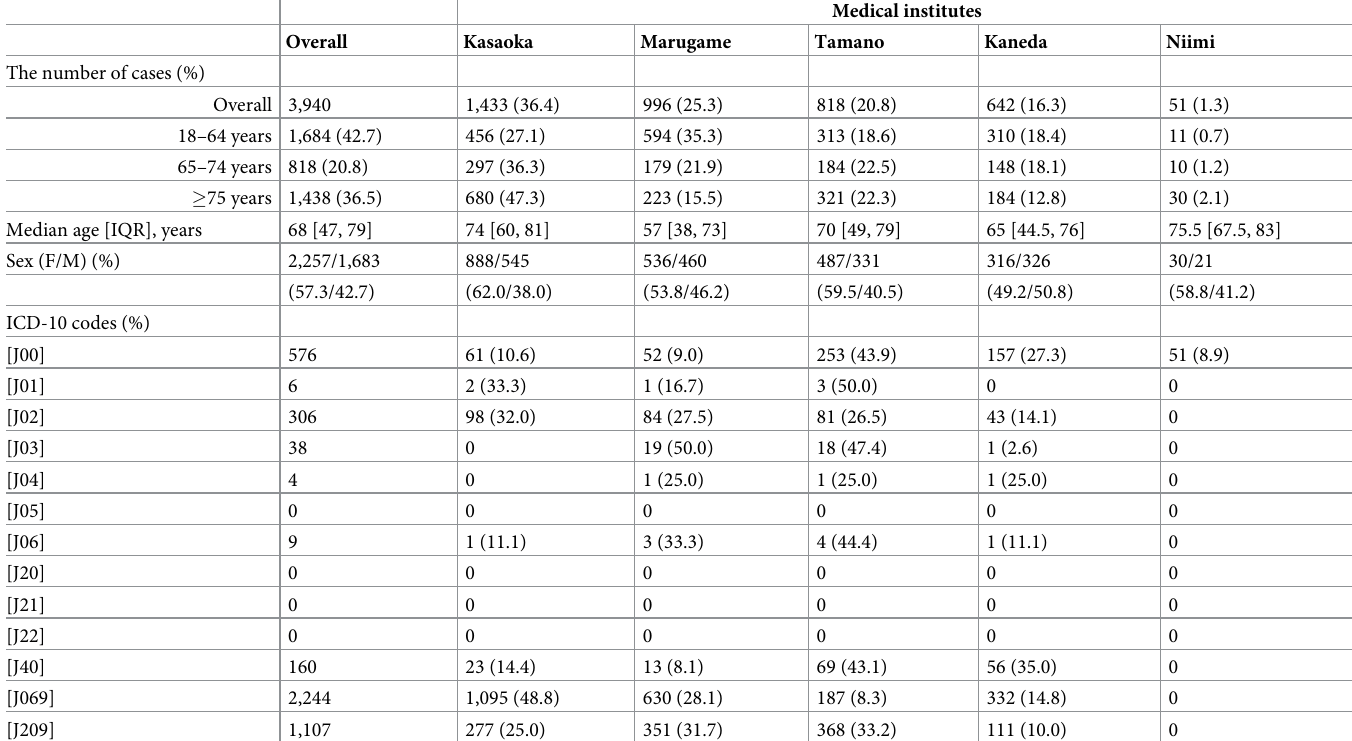
Table 1. Numbers and percentages of background data and diagnosis of the cases in each medical institute by age groups.